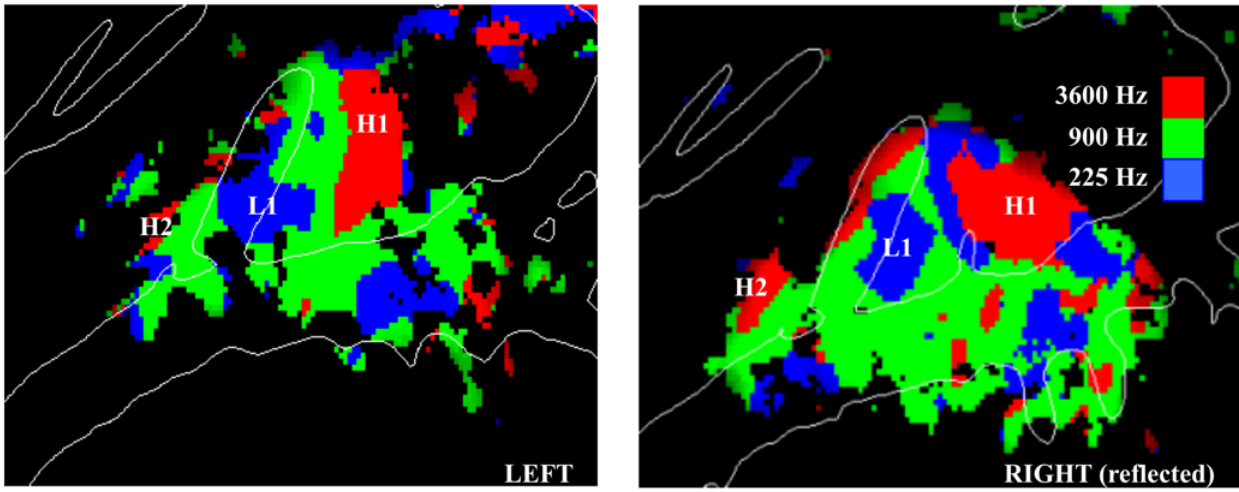
Figure 5. Mirror-image tonotopic organization of auditory cortex shown for the left and right (reflected) hemispheres. Plots show regions with significant activations coded by the frequency that produced maximal activation at that point. Red=3600 Hz, Green=900 Hz, Blue=225 Hz. Averaged over subjects, continuous and sparse sampling, sound spatial position, and sound intensity. Activation maps are shown on the average gyral structure (white lines) of the left and right hemispheres. z-score threshold=4.0. H1 and H2 identify posterior and anterior foci driven by high-frequency tones whereas L1 shows a central region driven by low-frequency tones.